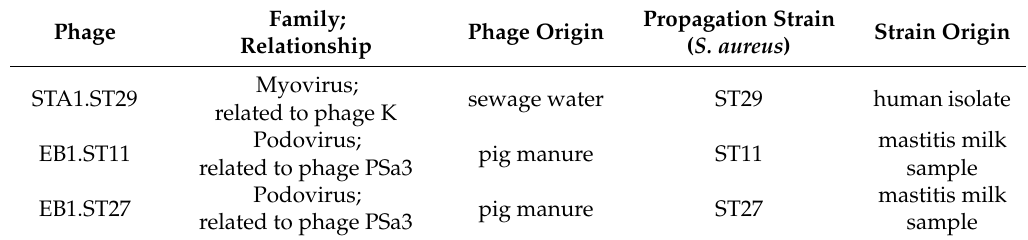
Table 1. Bacteriophages and Staphylococcus aureus propagation